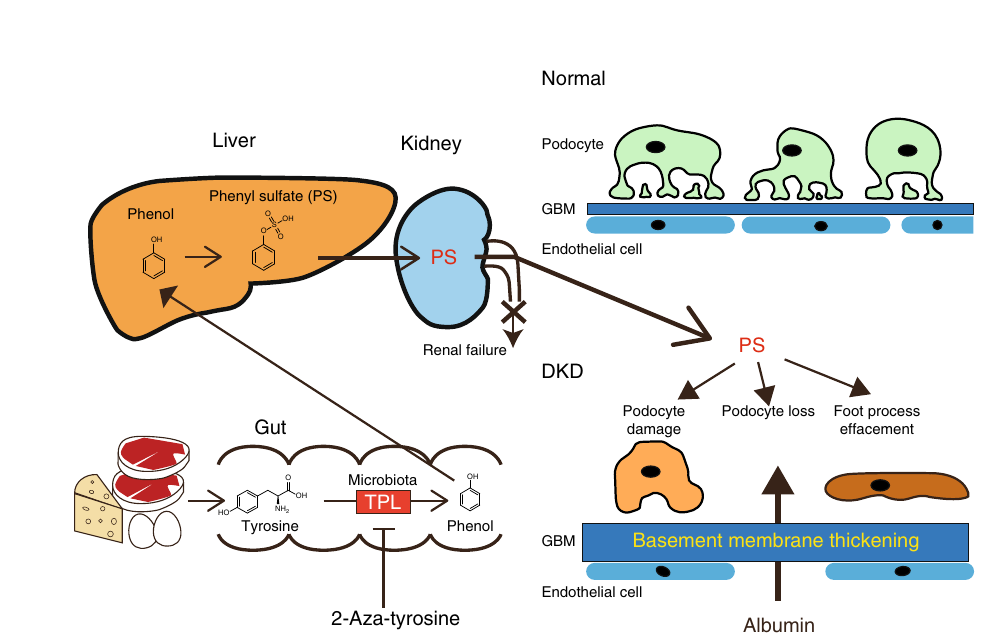
Fig. 5 Effect of 2-aza-tyrosine (AZA) on the gut microbiome in adenine-induced renal failure mice. a Observed OTUs rarefaction analysis. OTU rarefaction curves of gut microbiome were used to estimate richness in the following groups: control mice (Ctrl); control mice treated with 5 mg/kg 2-aza-tyrosine (AZA); adenine-induced renal failure mice (RF); and adenine-induced renal failure mice treated with 5 mg/kg 2-aza-tyrosine (RF-AZA). b OTU-based α - diversity of each microbiome. No signi fi cant diversity was seen in any group by Chao1 (left) and Shannon (right) analyses. c Principal coordinates analysis of the microbiome pro fi les using weighted UniFrac. Scores are presented for the fi rst principal component (PCo1) vs. both the second principal component (PCo2) and the third principal component (PCo3). d Relative abundance of microbiota based on the average number of each subgroup at order, family and genus levels. The major subgroups are indicated on the right. e The relative abundance of microbiota differed signi fi cantly among the four groups analyzed. The y -axis indicates the relative abundance of each microbe as a percentage. The proportional change in the minor groups correlated with renal failure and 2-aza-tyrosine treatment. The major microbial order (Bacteroidales, Clostridales, and Lactobacillales) were unchanged by either renal failure or 2-aza- tyrosine treatment. However, the minor populations ( Coriobacteriales and Erysipelotrichales ) were signi fi cantly changed in the correlation with the PS concentration by renal failure and 2-aza-tyrosine treatment. n = 5 in each group. Data were mean ± SEM. Statistical analysis was performed by the Tukey – Kramer test, followed by FDR correction of p values. * p FDR < 0.1 was treated as statistically signi fi cant. The following groups were tested: control group (Ctrl); control group administered 2-aza-tyrosine (AZA); the renal failure group (RF); and the renal failure group administered 2-aza-tyrosine (RF-